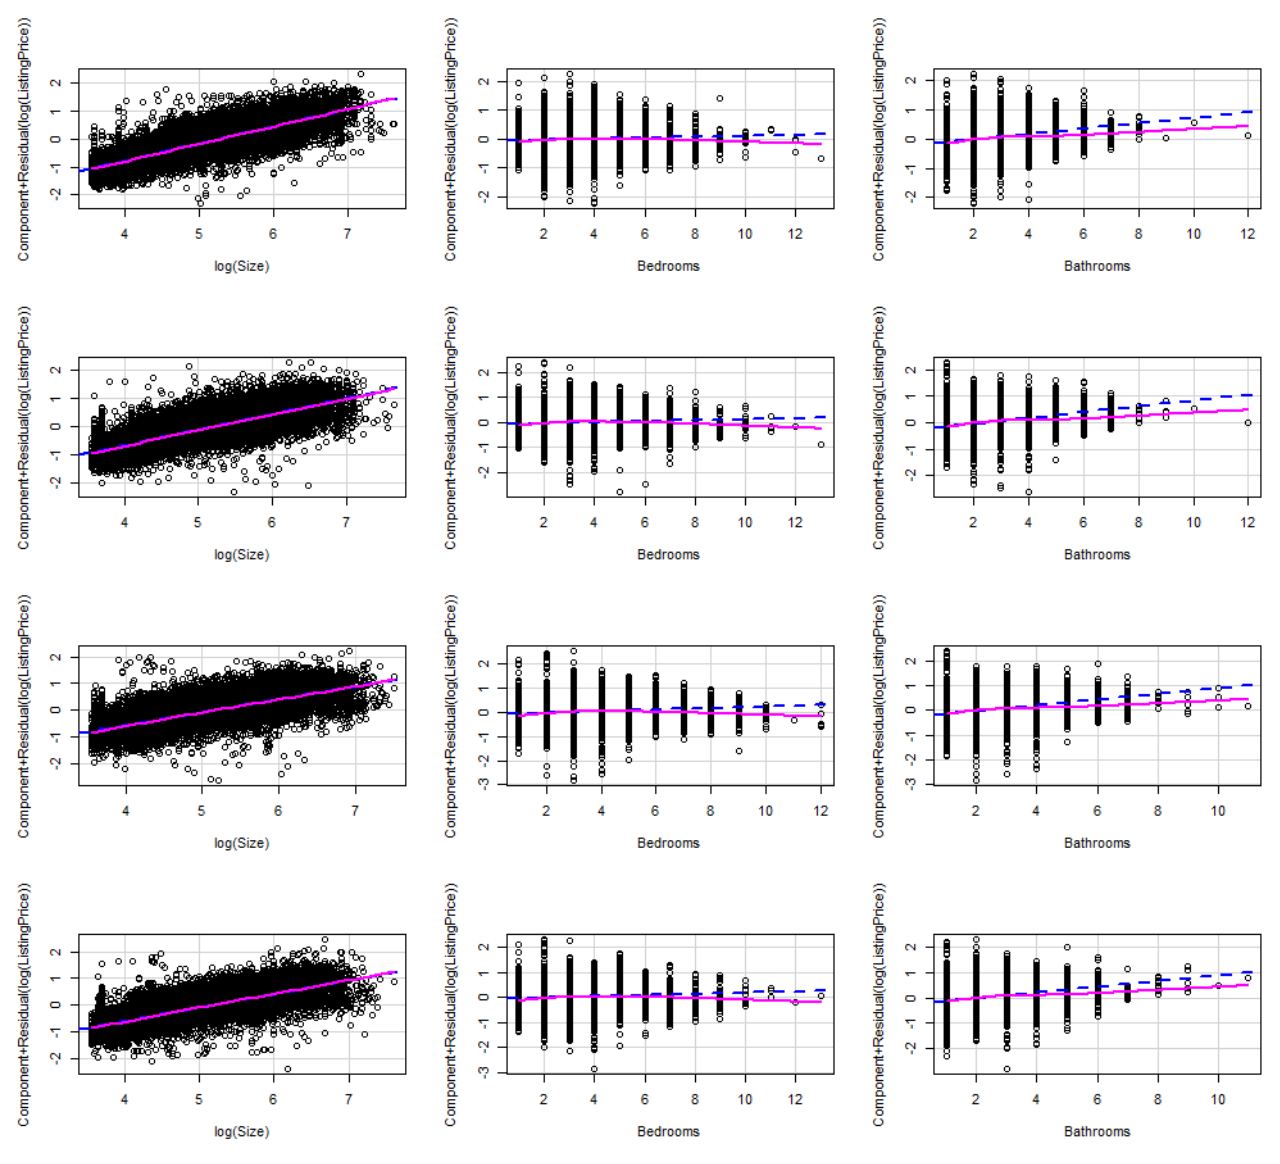
Figure 2: Log Linear Partial Residual